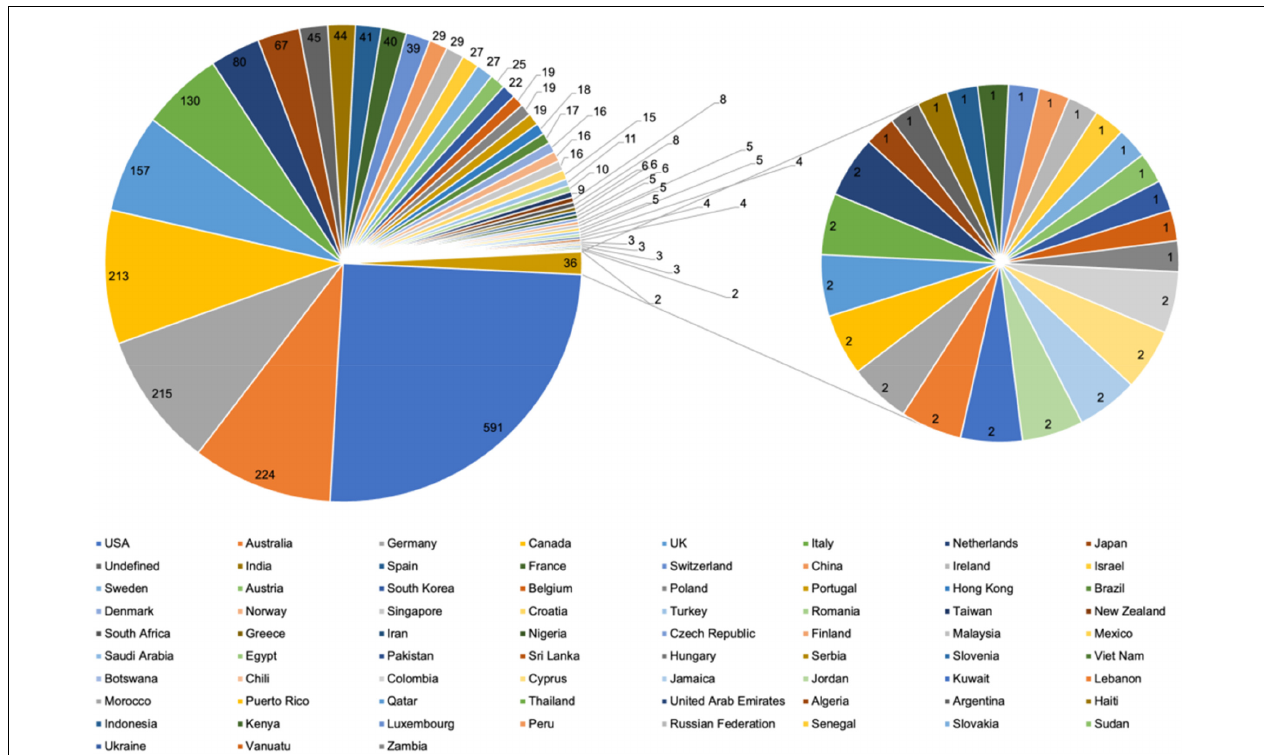
FIGURE 5 | Countries or regions participated in psycho-oncology research between 1980 and 2021.